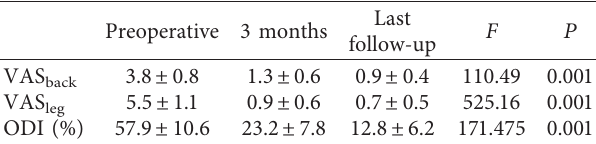
Table 2: Clinical outcomes.